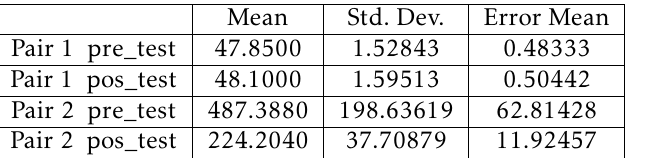
Table 1. Paired Samples Statistics - G1-PGS.